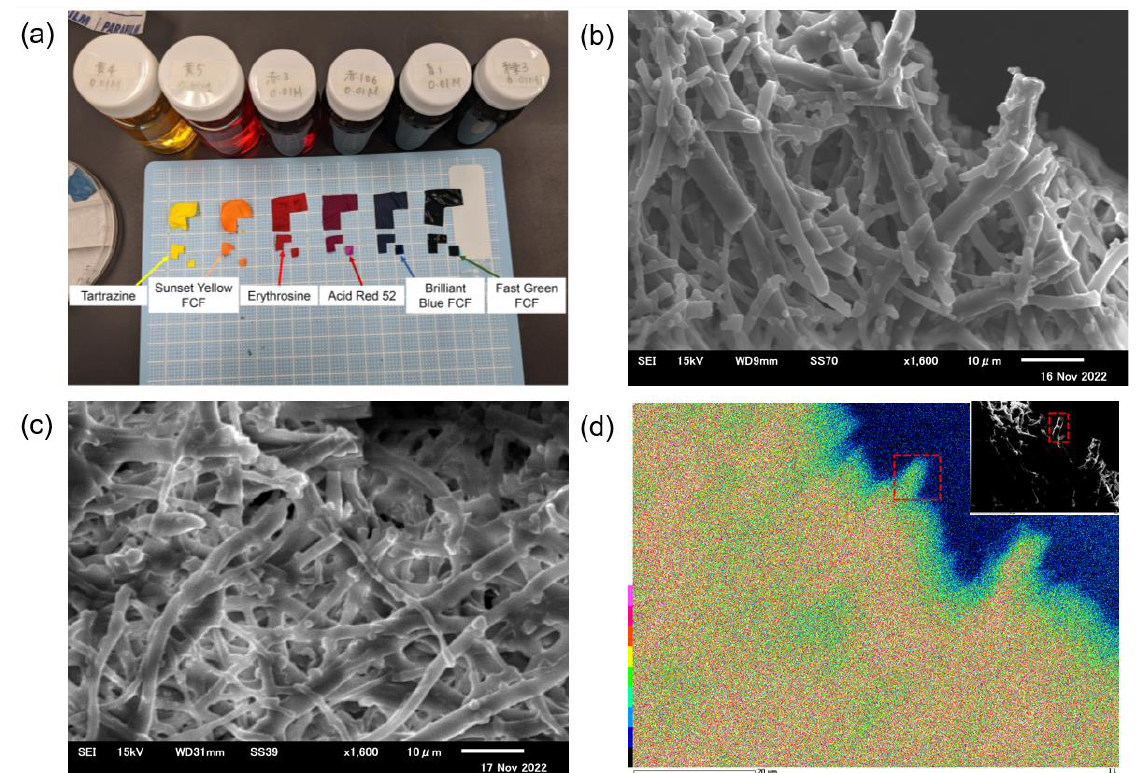
Figure 3. ( a ) The colors of the dye-ESM composites. The SEM images of the erythrosine-ESM com-